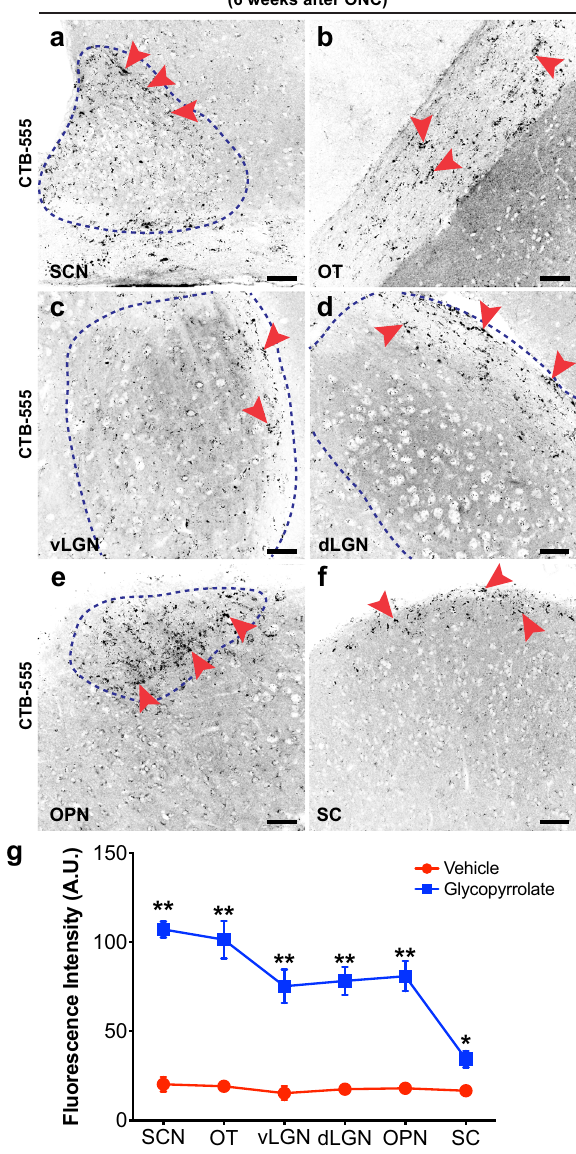
Fig. 8 Glycopyrrolate promotes re-innervation at multiple sub- cortical visual targets. a – f Representative confocal micrographs demonstrated that a considerable number of CTB-labeled regener- ating RGC axons were detected in ( a ) hypothalamic suprachiasmatic nucleus (SCN), ( b ) optic tract (OT), ( c ) thalamic ventral lateral geniculate nucleus (vLGN), ( d ) dorsal lateral geniculate nucleus (dLGN), ( e ) olivary pretectal nucleus (OPN), and ( f ) superior colliculus (SC) in glycopyrrolate-treated mice at 6 weeks post-ONC. Scale bars: 50 µm. g The fl uorescent intensity of CTB-positive axons in multiple visual targets of glycopyrrolate-treated mice was signi fi cantly higher than the vehicle-treated mice. Mean ± SEM ( n = 3 – 4 per group). * P < 0.05, ** P < 0.01; Student ’ s t